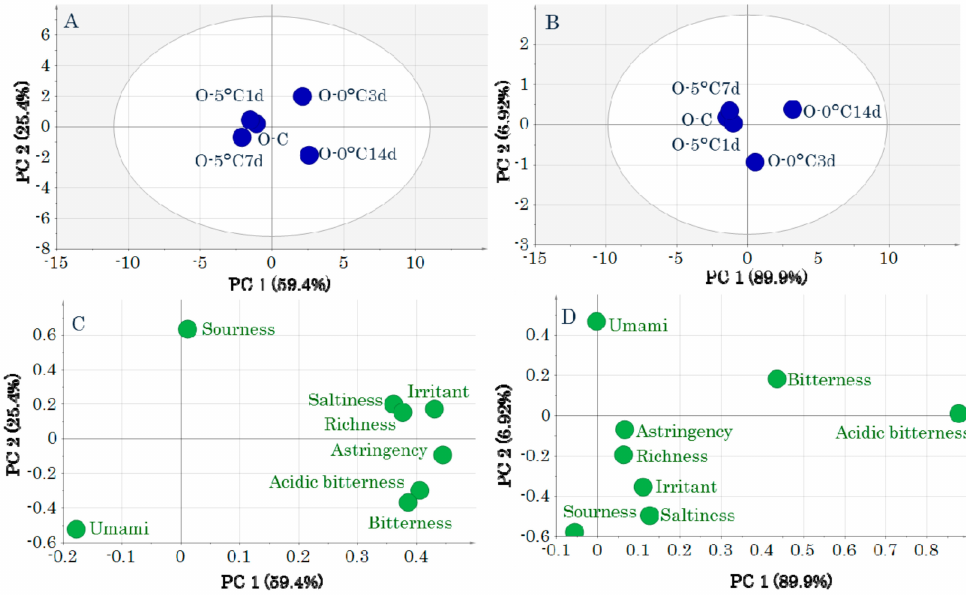
Figure 3. Score plots ( A , B ) and loading plots ( C , D ) obtained by a principal components analysis of taste-attribute profiles in ordinary muscle samples. Data were pretreated with unit variance scaling ( A , C ) and pareto scaling ( B , D ). Symbols in score plots ( A , B ) indicate sample IDs (Table